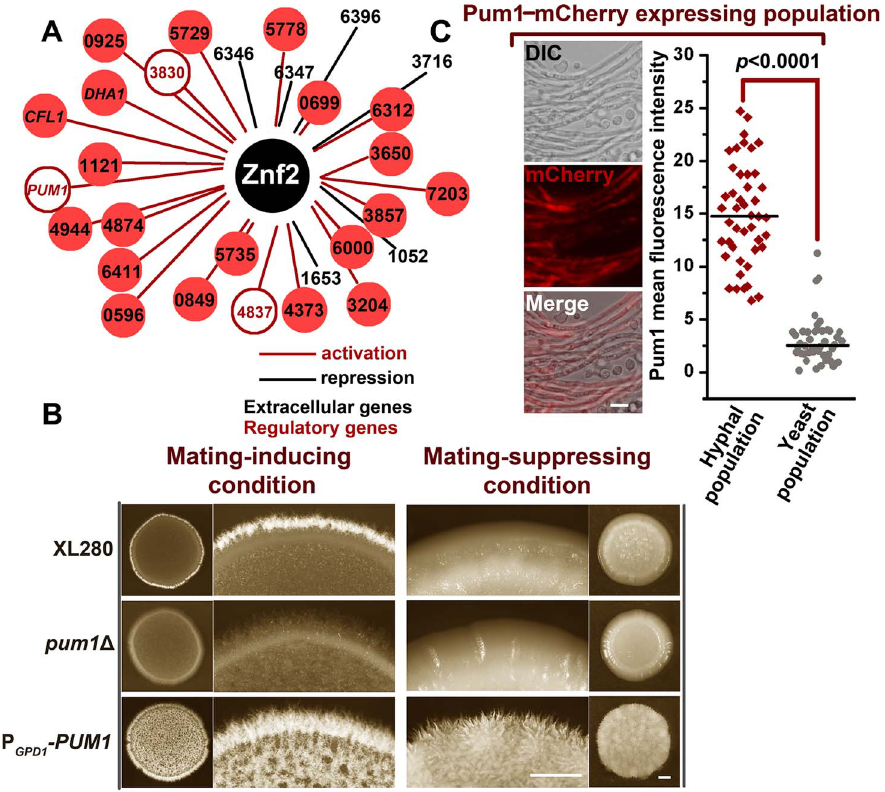
Figure 2. The Znf2 downstream target Pum1 directs filamentation. (A) The 29 Znf2 downstream targets were placed under the control of the constitutive P GDP1 promoter to construct a Cryptococcus overexpression library. The screen for their effects on filamentation was conducted under filamentation-suppressing or filamentation-inducing conditions with a 5-day incubation period. CNAG_0‘number’ indicates the gene locus name used in Broad Institute C. neoformans H99 sequence annotation, and these locus names were used because they are previously uncharacterized genes. The gene locus number of PUM1 is CNAG_04003. (B) Pum1 positively controls filamentation. The overnight cultures of the wildtype strain XL280, the pum1 D mutant, and the PUM1 overexpression strain of the same cell density were dropped onto the V8 agar (mating-inducing) or the YPD agar (mating-suppressing) and photographed after 5 days of growth. Scale bar: 1 mm. (C) The Pum1-mCherry shows a biased expression in the hyphal subpopulation. The images of the fluorescence labeled wildtype strain were taken at 72 hrs post mating stimulation. The localization patterns of Pum1 in the figure are representative for each given cell types (at least 40 cells for each cell type were examined). See [Materials and Methods] for the detailed description of the experimental condition for the sub-cellular localization of Pum1-mCherry. Scale bar: 10 m m.